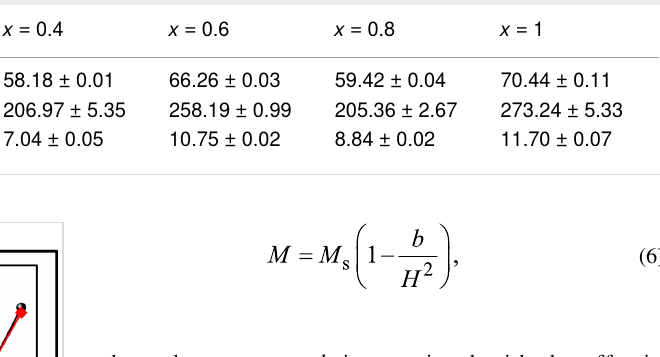
Table 2: Saturation magnetization ( M S ), coercivity ( H C ) and remanence ( M r ) of the Co x Fe 3 − x O 4 samples at room temperature.